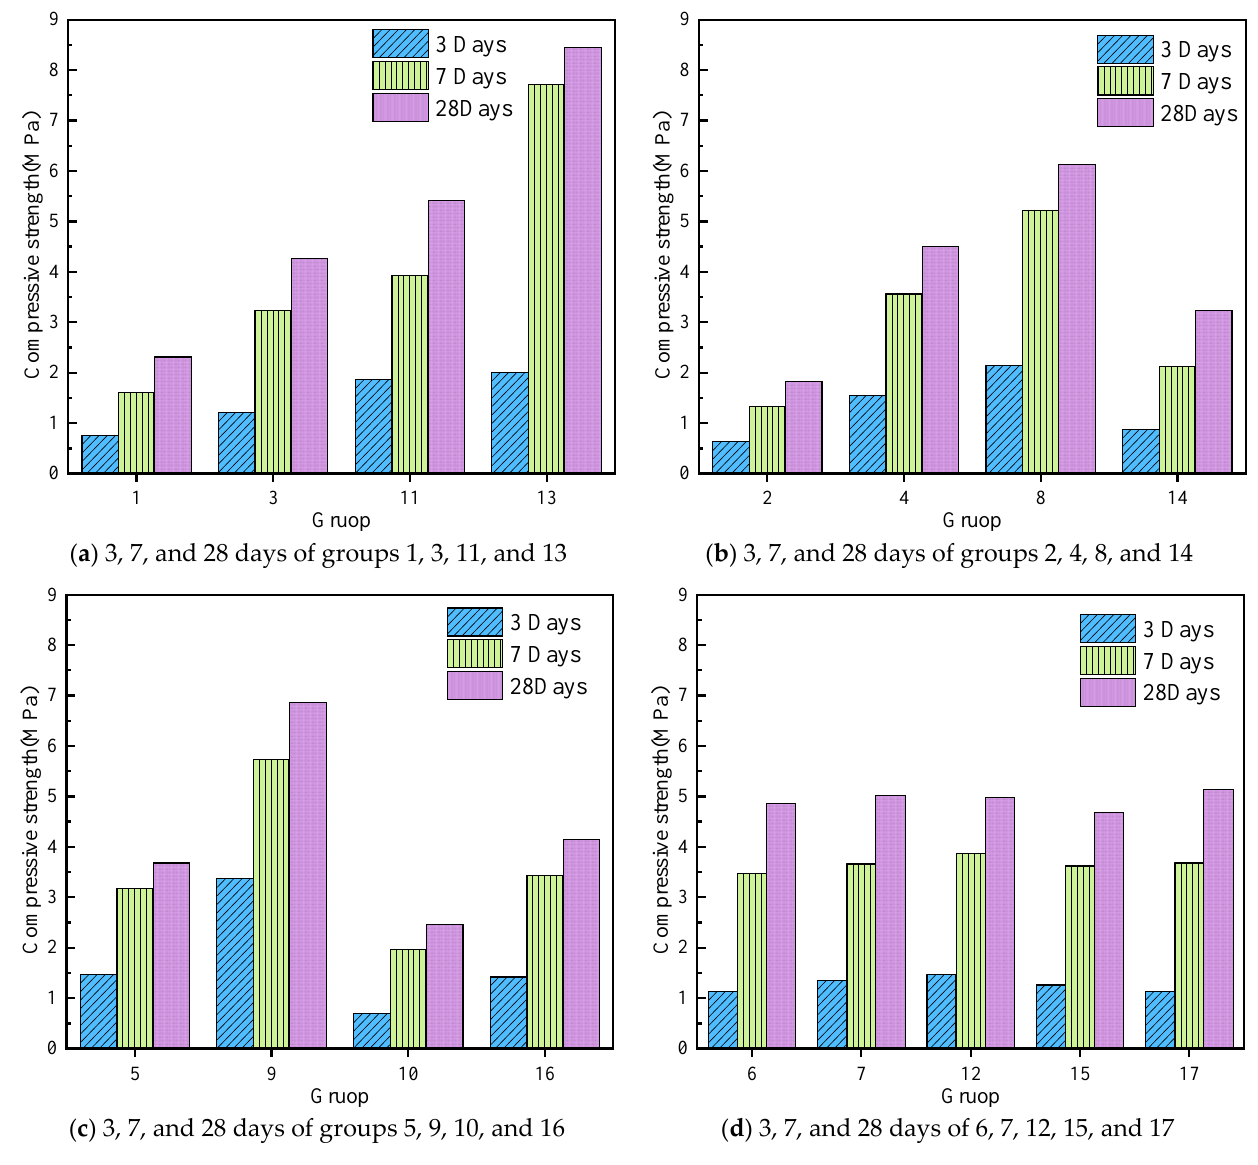
Figure 6. The strength of grout stones in different curing periods. ( a ) 3, 7, and 28 days of groups 1, 3, 11, and 13; ( b ) 3, 7, and 28 days of groups 2, 4, 8, and 14; ( c ) 3, 7, and 28 days of groups 5, 9, 10, and 16; ( d ) 3, 7, and 28 days of 6, 7, 12, 15, and 17.